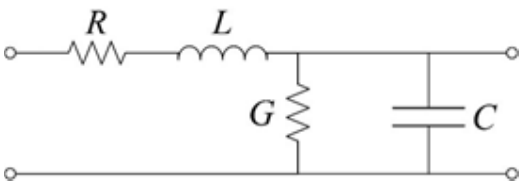
Figure 3. Transmission line structure for a single unit length.